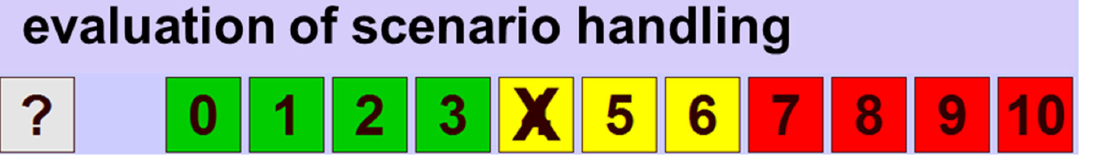
Figure 1. Experimenter global rating of the driver’s handling of a use case in a specified scenario. The cross marks an exemplary rating.